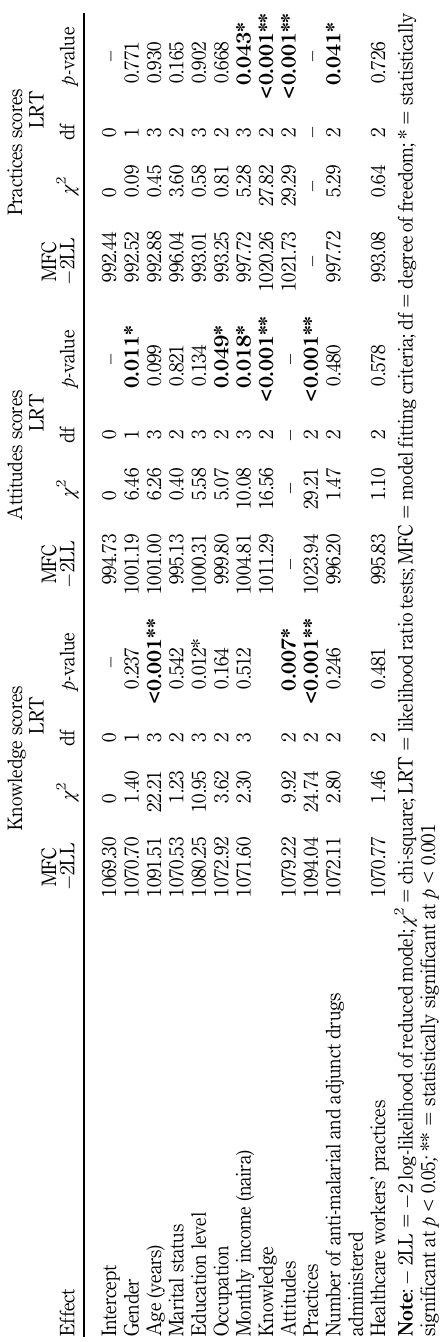
Table V. Multinomial logistic regression between patients ’ independent variables and KAP scores ( N 5